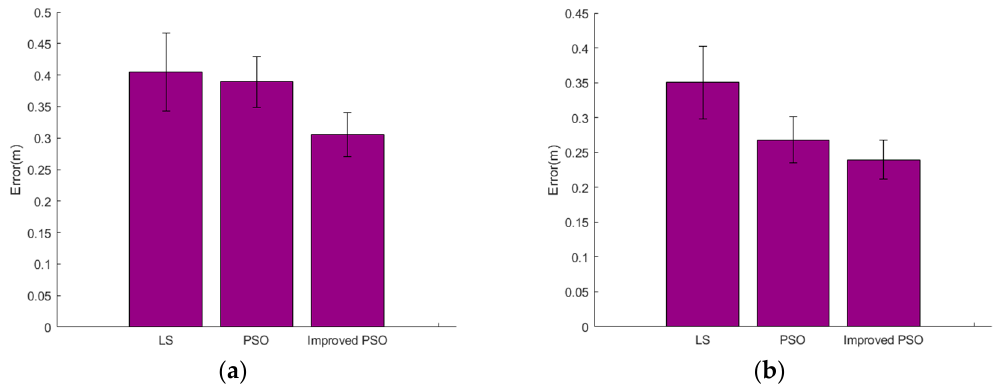
Figure 4. Localization accuracy of the proposed method, compared with Least Squares (LS)-based optimization. ( a ) Results with reflective box target. ( b ) Results with human target.